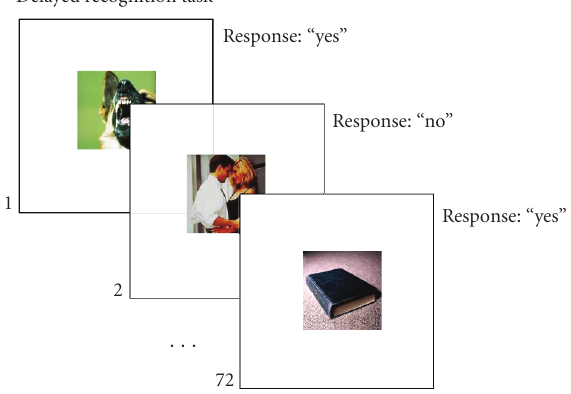
each dimension, using the Self-Assessment Manikin